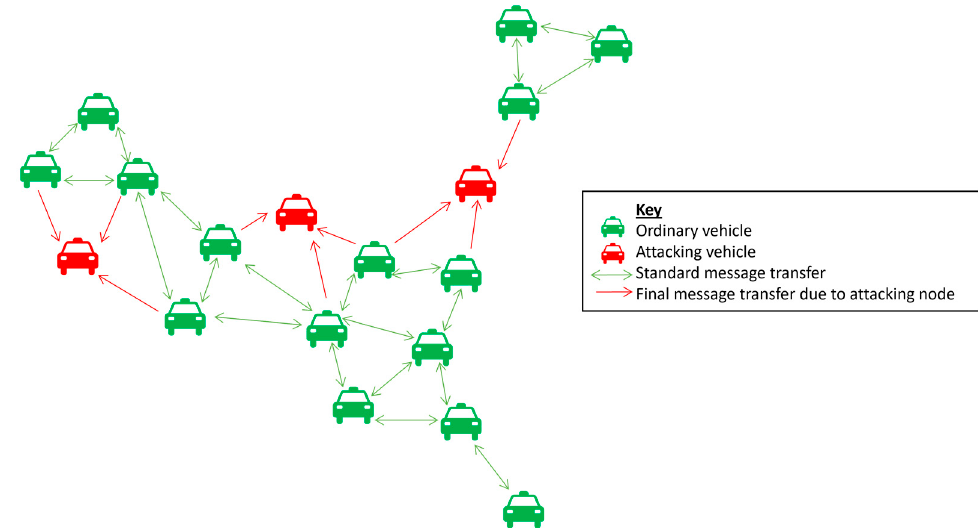
Figure 3. Diagram to show vehicular nodes communicating.